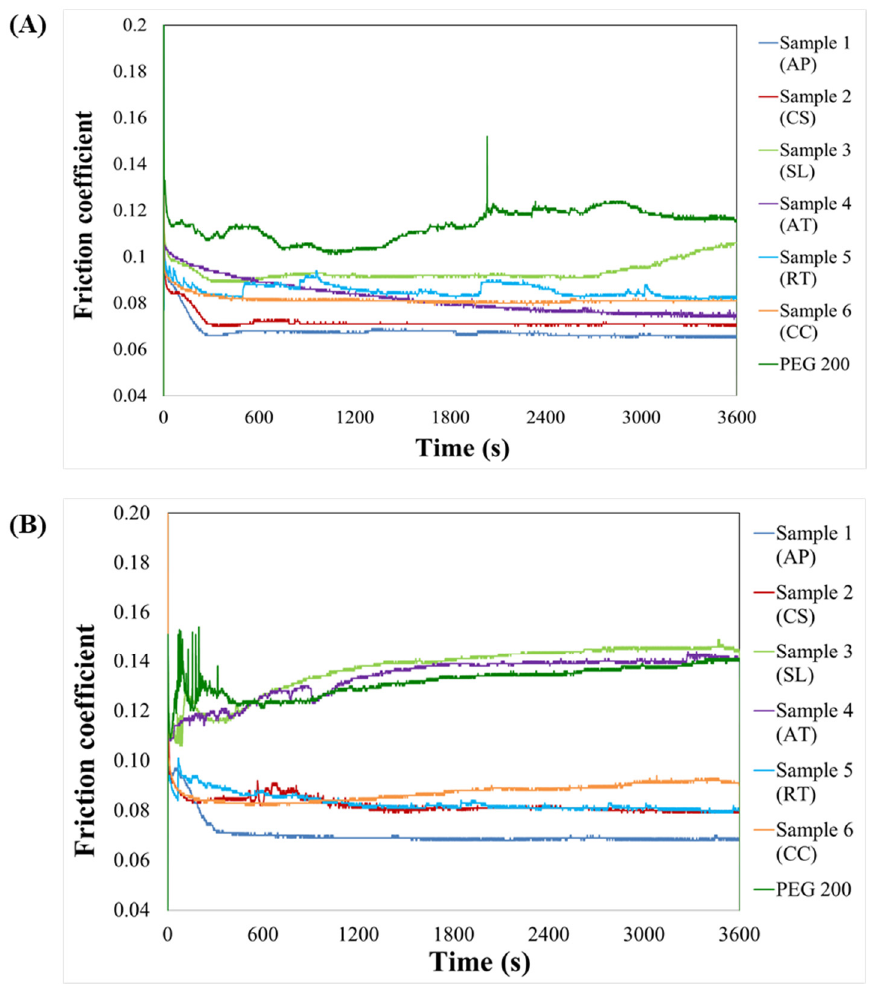
Figure 4. Friction coefficient of different microbial oils ( A. protothecoides (AP), C. sorokiniana (CS); thraustochytrids S. limacinum (SL), Aurantiochytrium sp. T66 (AT) and yeasts R. toruloides (RT) and C. curvatus (CC) and PEG 200 as control, determined under load of ( A ) 2.0 GPa or ( B ) 2.5